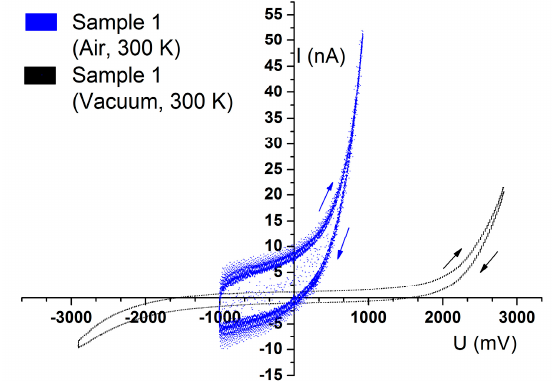
Figure 8. VACs of Al/nc-Si/Al structures measured at 300 K: (blue curve) at ambient conditions, (black curve) in vacuum (~10 − 2 То rr).